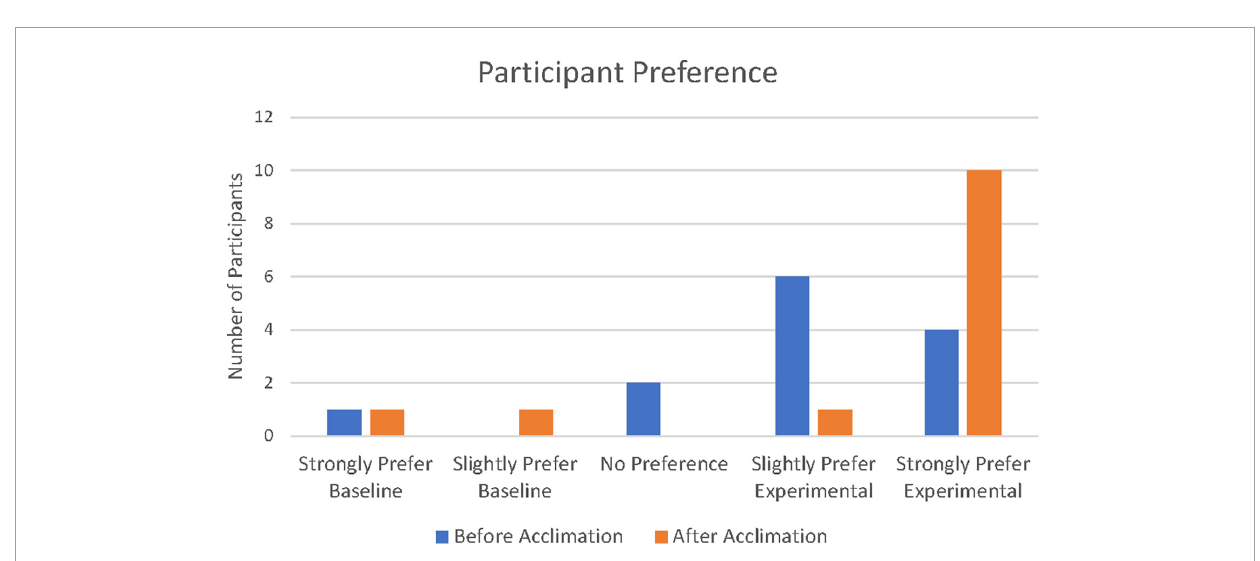
FIGURE6 Participant preferences on a blinded preference evaluation comparing the baseline program to the experimental program. Blue bars represent preference prior to acclimation and orange bars represent preference after